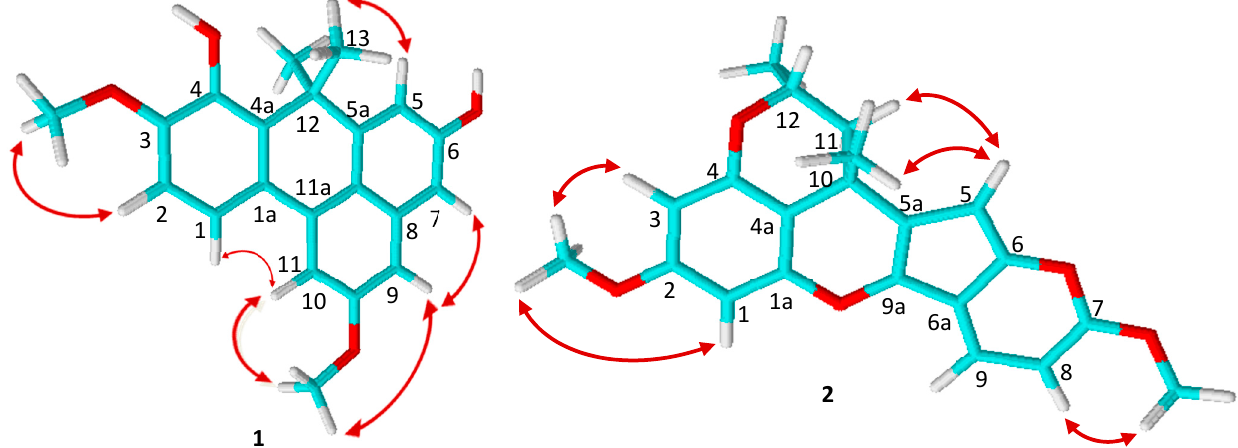
Figure 4. Key NOESY correlations for compounds 1 and 2 . Compound 2 was isolated as a brownish powder amorphous solid. It gave [M + H] + at m/z 353.1386 in HRESIMS consistent with the molecular formula C 21 H 20 O 5 . All 1 H (Figure S1), 13 C (Figure S3), and J-modulated spin-echo (JMOD) NMR assignments for compound 2 were performed using 2D NMR spectroscopic data (HSQC (Figure S3), HMBC (Figure S4), COSY (Figure S5), NOESY (Figure S6)). Analysis of the 1 H NMR spectrum in methanol- d 6 (Table 4) displayed signals of two meta -coupled aromatic protons δ H 6.63 (1H, d, J = 2.2 Hz, H-1) and δ H 6.27 (1H, d, J = 2.2 Hz, H-3), two ortho -coupled aromatic protons δ H 6.76 (1H, d, J = 8.4 Hz, H-8) and δ H 6.65 (1H, d, J = 8.4 Hz, H-9), one aromatic proton as a singlet δ H 6.66 (1H, s, H-5), two methyls, two methylenes, one sp 3 methine, and signals of protons belonging to two methoxyls. In the JMOD spectrum, the presence of 21 carbon signals was detected (Table 3). Table 4. NMR spectroscopic data for compound 2 (400 MHz, Methanol- d 4 ). Position